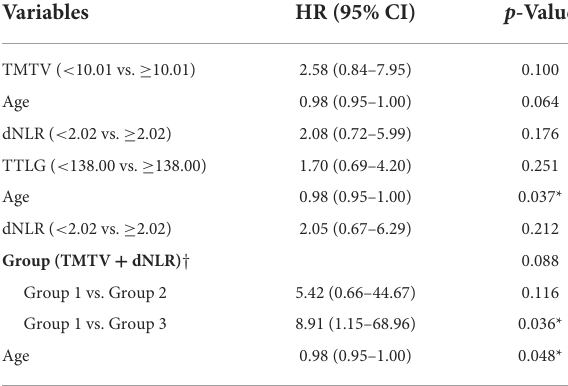
TABLE 3 Multivariable analysis for PFS by Cox proportional hazard